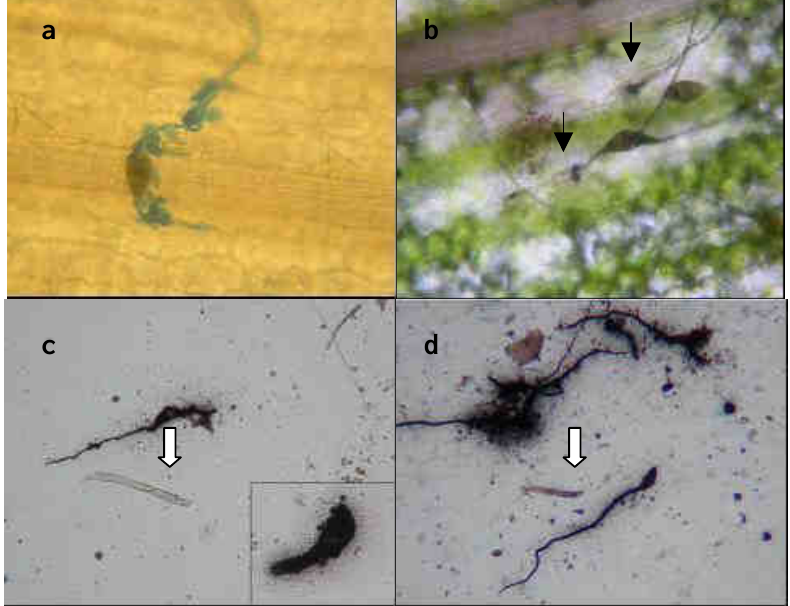
Figure 1. Esterases around the surface of germinating conidia